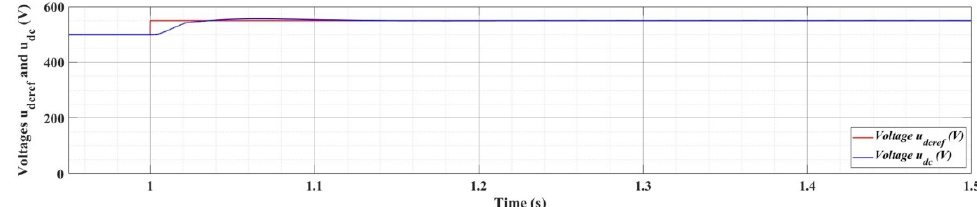
Figure 35. The time evolution of the u dc voltage for a step variation of the u dcref reference voltage from 500 V to 550 V using PI controllers and the RL-TD3 agent for the correction of the u dref and u qref commands (signal evolution of the type 1 PV array).